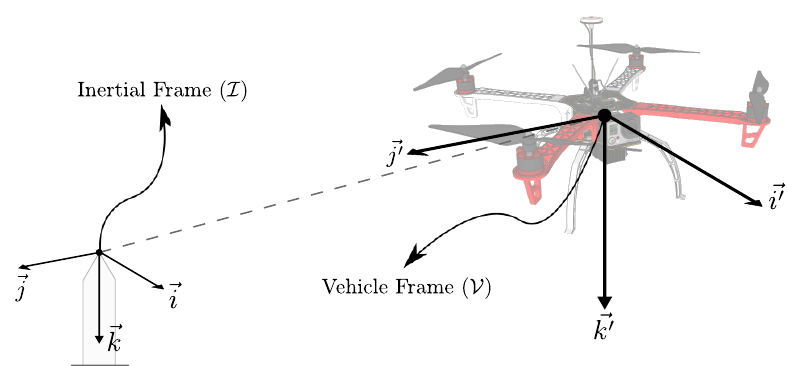
Figure 1. Configuration of a quadrotor considering the inertial frame ( I ) and the vehicle frame ( V ).